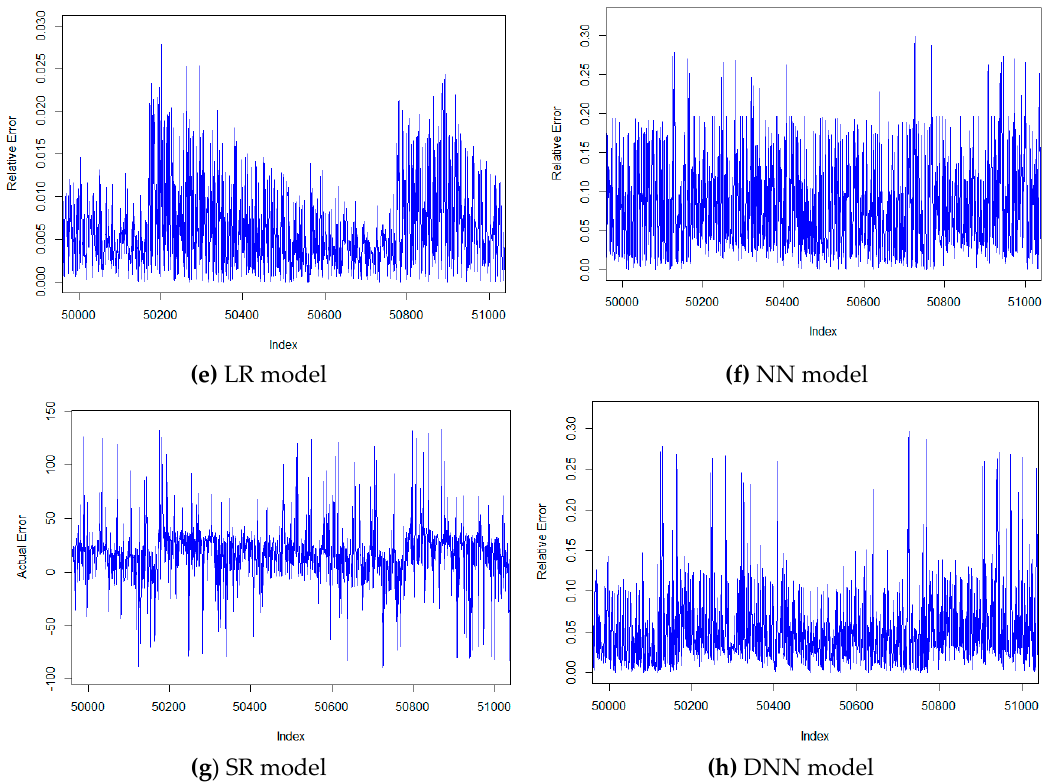
Figure 6. Relative error of ARDL model for predicting the HPTET temperature with different lag steps. Figure 6 contains eight graphs, which were listed as follows: ( a ) ARDL model with lag 1, ( b ) ARDL model with lag 5, ( c ) ARDL model with lag 10, ( d ) ARDL model with lag 15, ( e ) LR model, ( f ) NN model, ( g ) SR model, ( h ) DNN model.